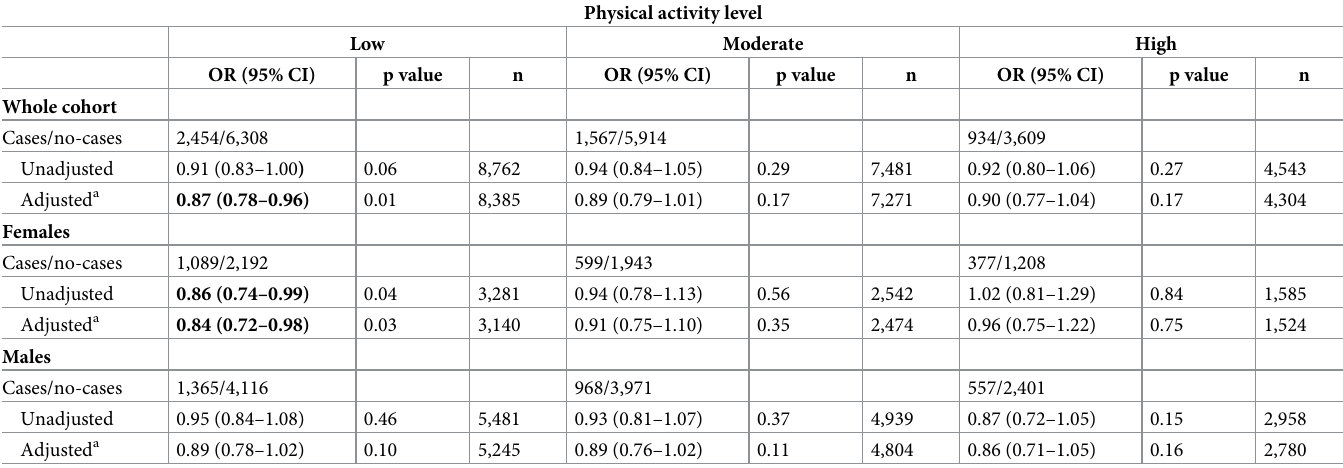
Table 2. Association between metformin and back pain considering different levels of physical activity engagement.